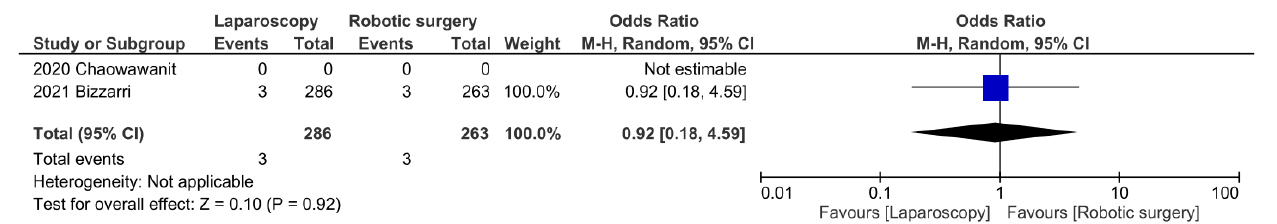
Figure 9. Forest plot of individual and pooled odds ratios, with 95% confidence interval (CI), for number of dissected SLN: 6, comparing laparoscopy and robotic surgery for SLN biopsy in EC women.